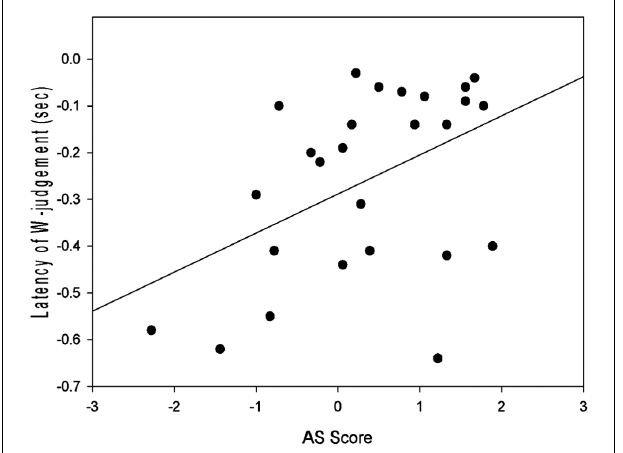
FIGURE 1 | Prediction of MeanW-judgment scores from attributional style scores (AS Score), with linear regression ( R 2 = 0.32, p = 0.015).